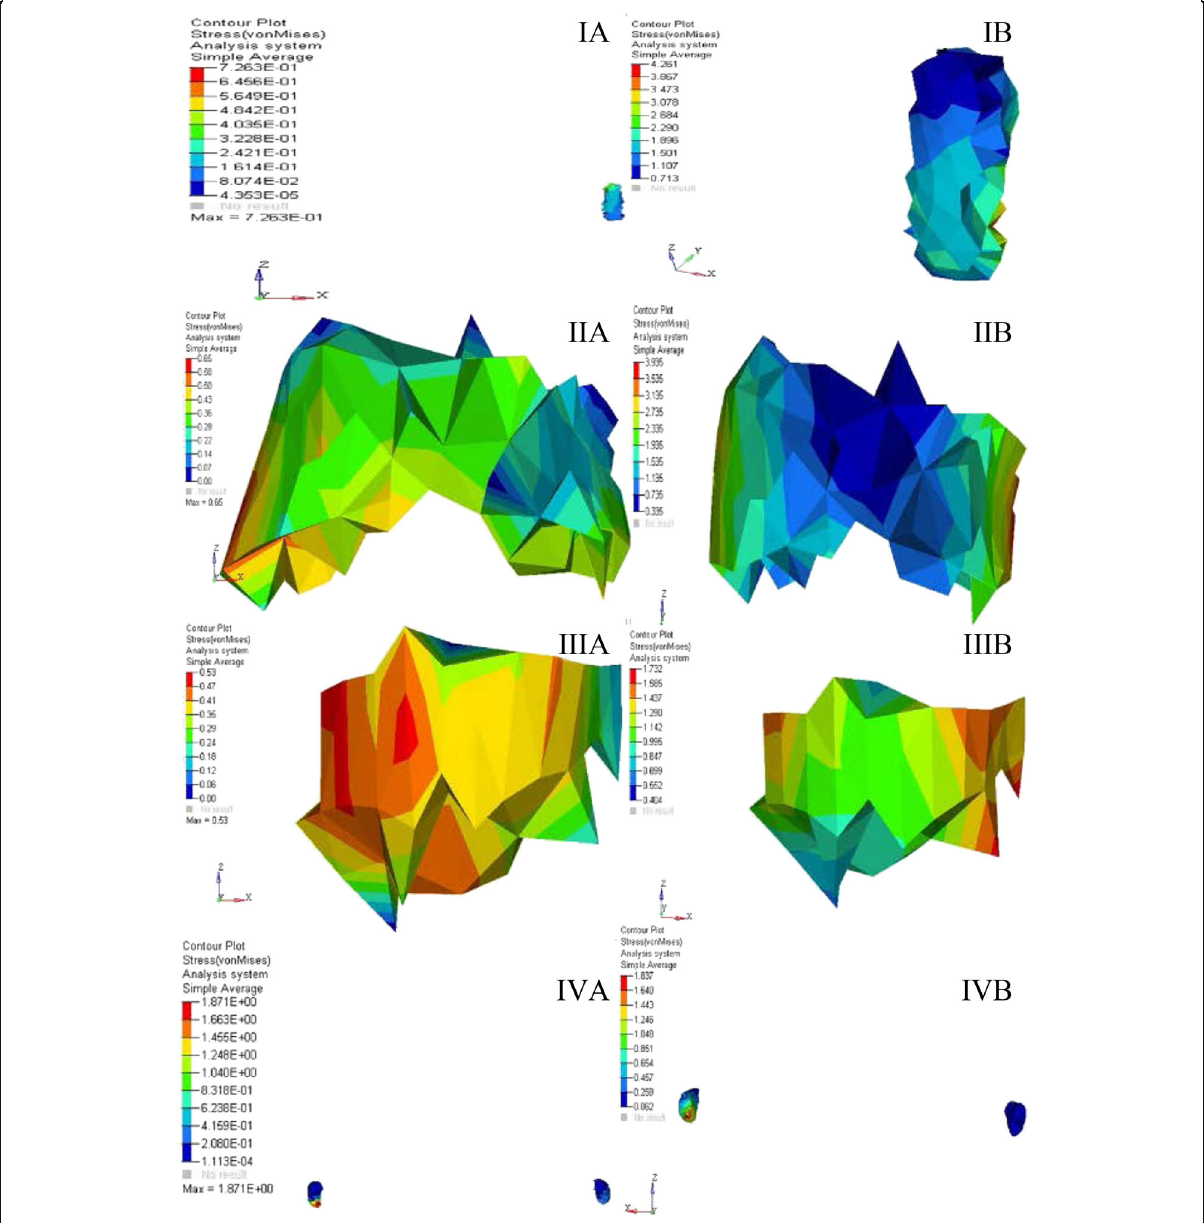
Fig. 8 von Mises stresses at different sutures for A RME. B Implant-supported RME. IA , IB Intranasal suture. IIA , IIB Frontomaxillary suture. IIIA , IIIB Naso-frontal suture. IVA , IVB Zygomatico-temporal